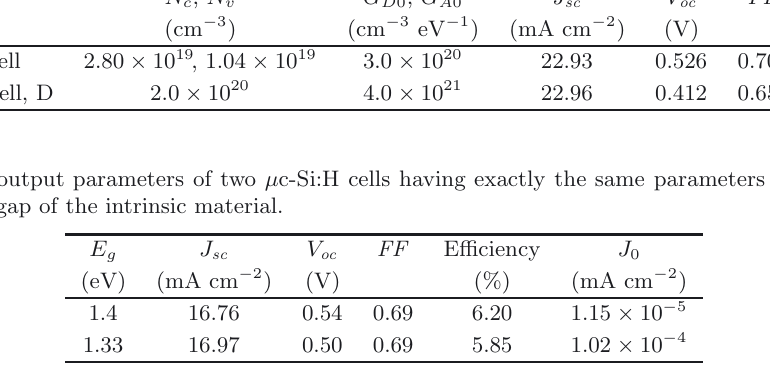
Table 3. The solar cell output of the fluorinated μ c-Si:H solar cell compared to the output of a hypothetical cell having higher effective DOS at the band edges and higher exponential tail pre-factors.